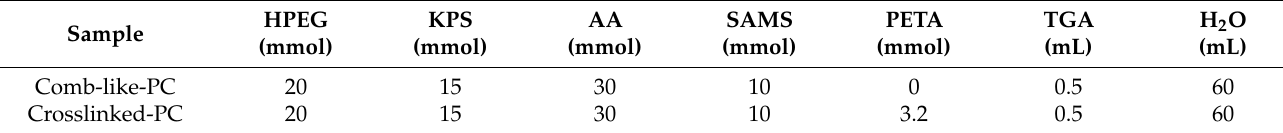
Figure 1. Synthetic routes for the preparation of the comb-like-PC and crosslinked-PC. Table 1. Monomer combination in synthesis of the